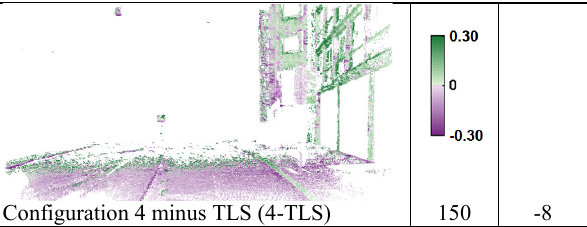
Table 5. Point clouds generated by the SURE triangulation